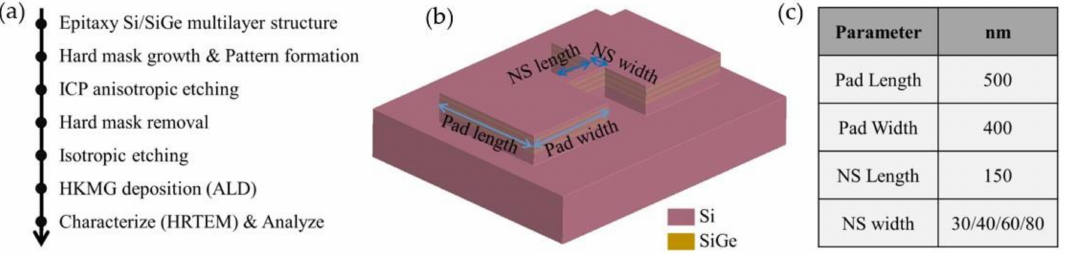
Figure 1. ( a ) The main fabrication process flow of vertically stacked horizontal nanosheets. ( b ) 3D schematic diagram of the test pattern after the step of hard mask removal. ( c ) Summary of the parameters of the test pattern. (Inductively coupled plasma: ICP; High k dielectric and metal gate: HKMG; Atomic layer deposition: ALD).